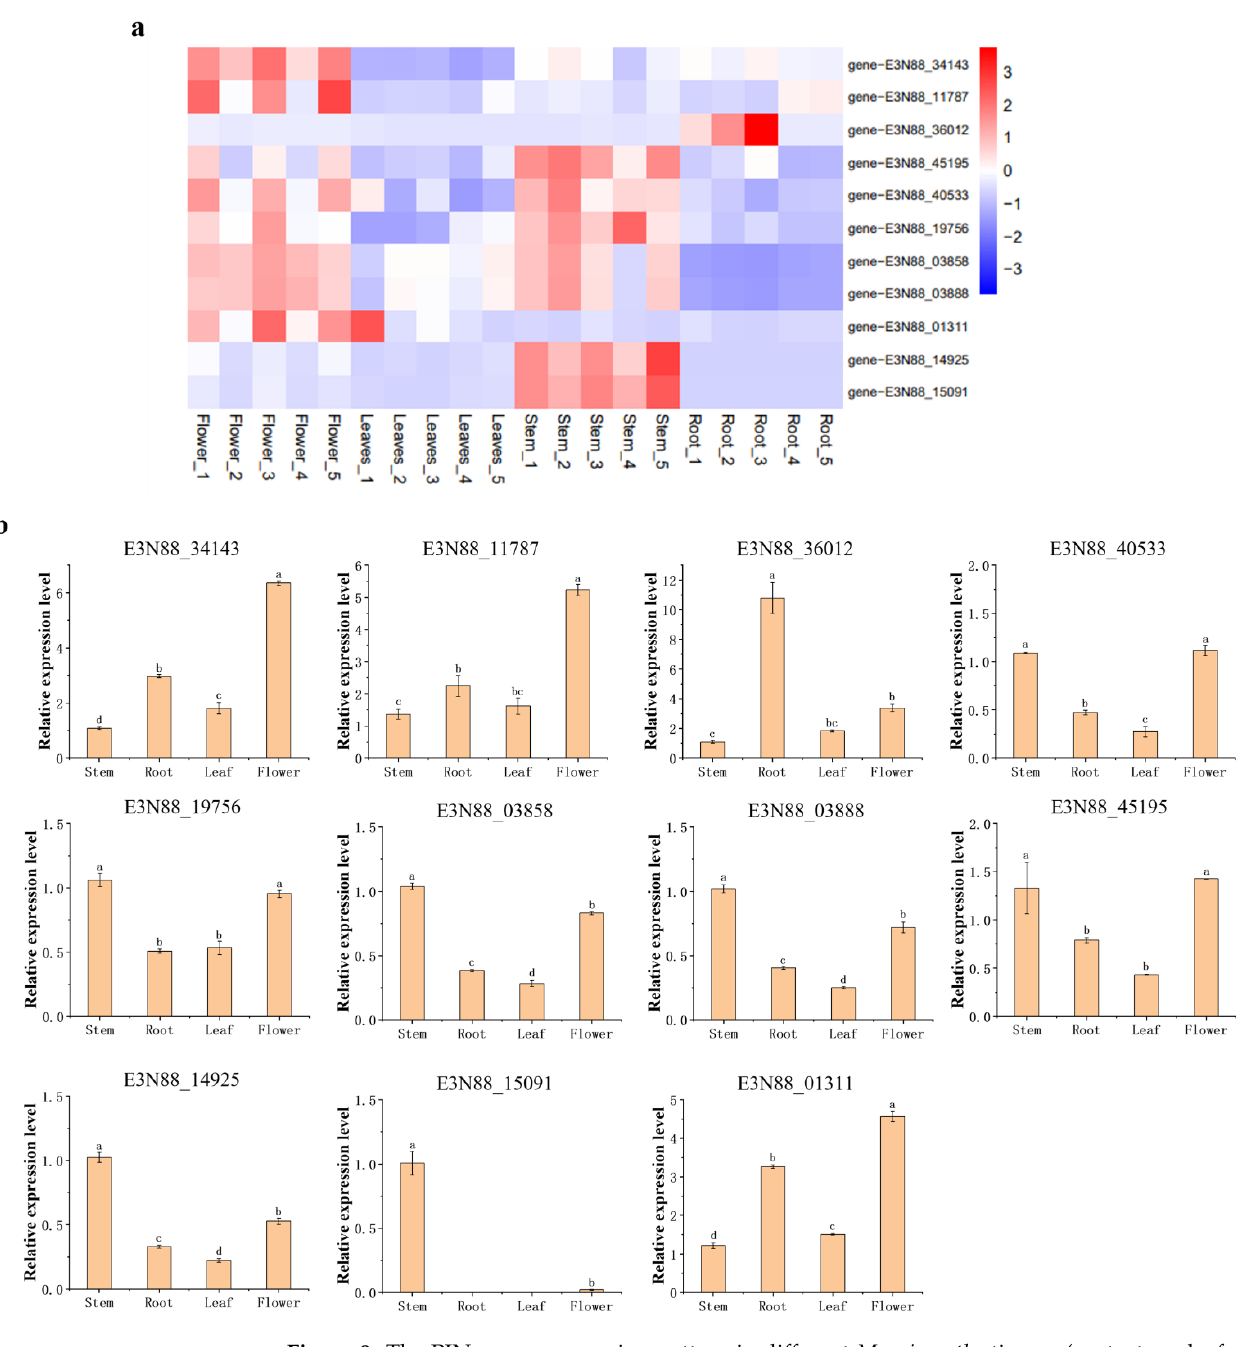
Figure 8. The PIN genes expression pattern in different M. micrantha tissues (root, stem, leaf and flower). ( a ) Expression heatmaps of PIN genes in different tissues. The FPKM values were trans- formed to log2 (value + 1). The color scale is shown at the right, and higher expression levels are shown in red. ( b ) Relative expressions of PIN genes in different tissues. The histogram represents the relative expression level of PIN genes in different tissues compared with the expression level in stem, which was normalized to a value of 1. The error bars represent the standard errors (SEs) of three to seven biological replicates.